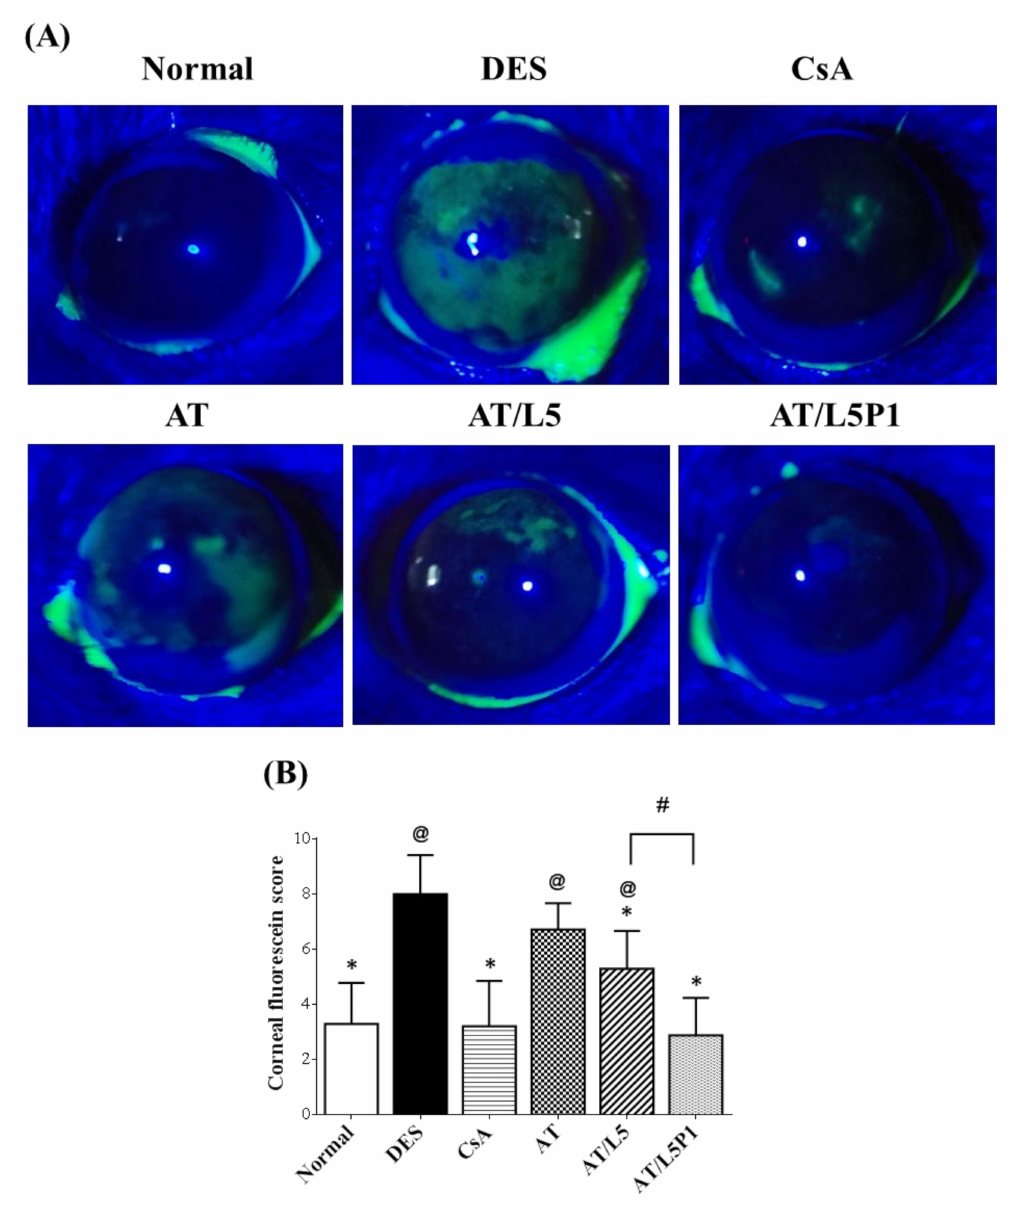
Figure 6. Corneal fluorescein staining of DES mice after 10 days treatment. ( A ) Slit-lamp photography of the mouse eyes in each group. ( B ) Cornea grading according to the National Eye Institute scale. Data were analyzed using the one-way ANOVA and are expressed as the mean ± standard deviation (SD); n = 6, (@ p < 0.05 compared with the control group, * p < 0.05 compared with the DES group, # p < 0.05 compared with the